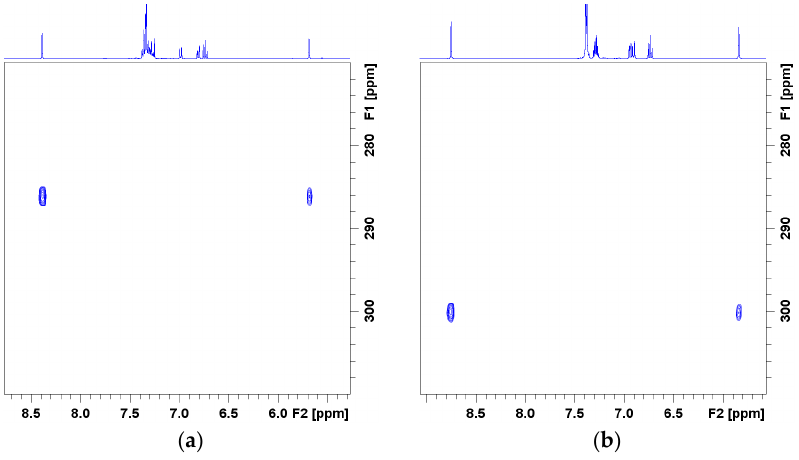
Figure D9. 1 H– 15 N HMBC NMR spectra of oOHsaladpm in ( a ) CDCl 3 and ( b ) DMSO-d 6 .